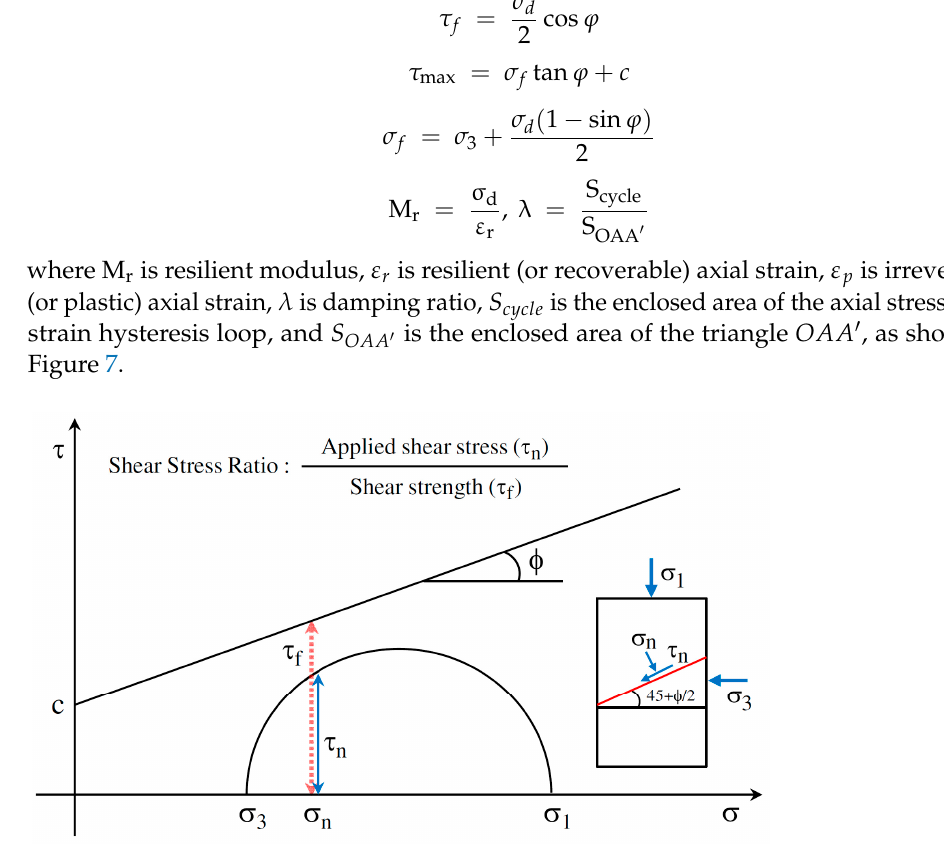
Figure 5. Illustration of the definition of the shear stress ratio ( SSR ). Table 2. The loading scheme adopted for laboratory repeated load triaxial tests.